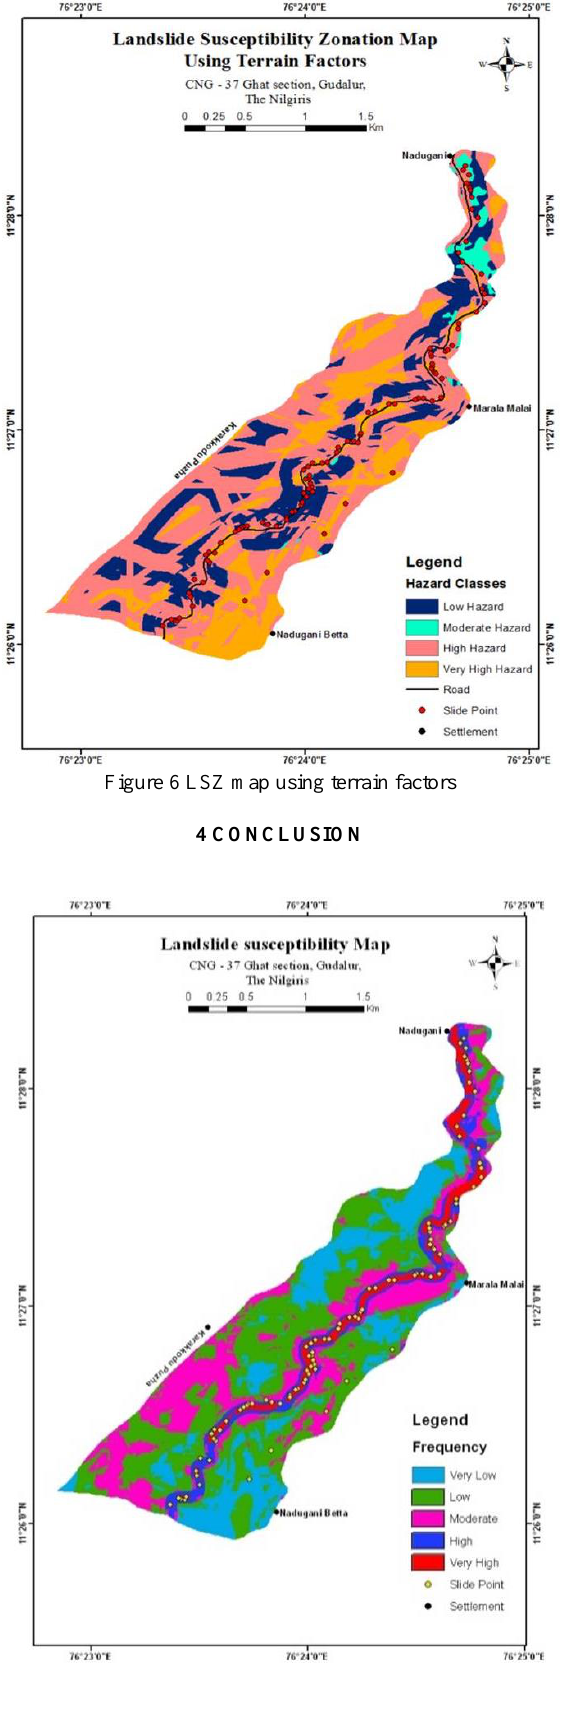
Figure LSZ map using hydrological, geological, and